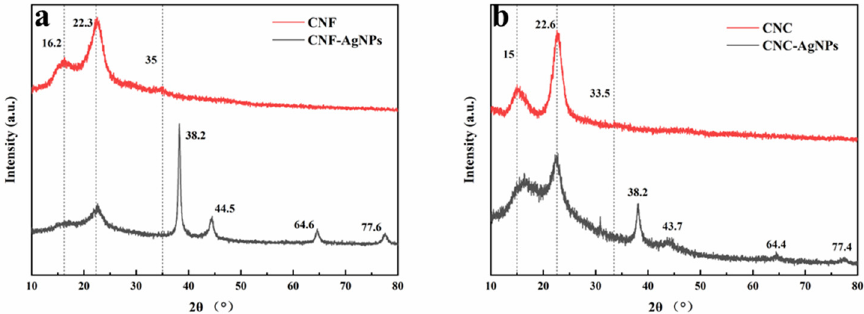
Figure 3. XRD pattern of nanocellulose and NC-AgNPs. ( a ) CNF and CNF-AgNPs, ( b ) CNC and CNC-AgNPs.